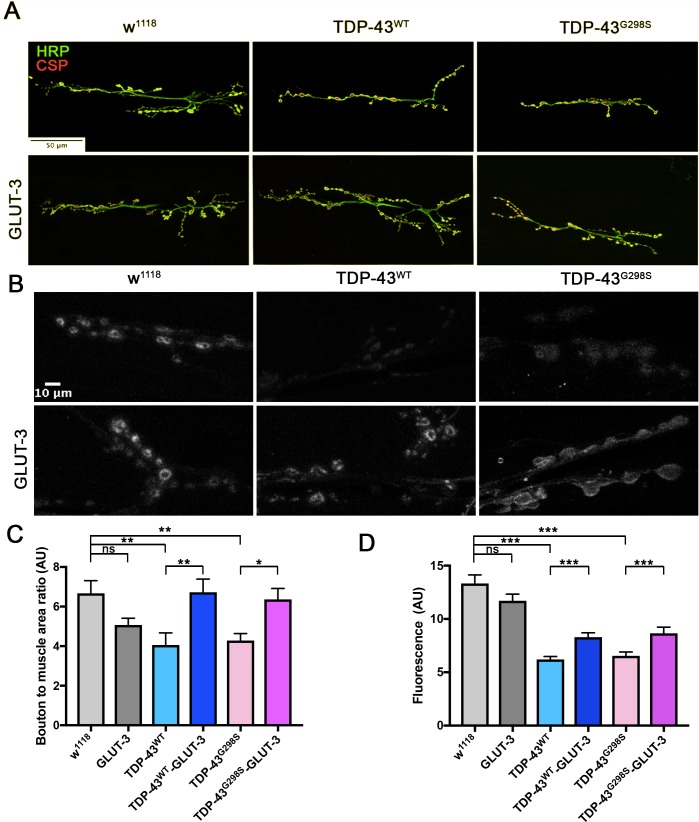
TDP-43 dependent defects at the NMJ are rescued by GLUT-3.Third instar larvae NMJ from segment A3, muscle 6/7 were immunostained for CSP and HRP (A) or analyzed for their ability to endocytose FM1-43 dye upon stimulation with 90 mM KCl (B). (A, C) Neuronal TDP-43 expression in Drosophila neurons reduces the number of boutons (labeled with CSP and HRP (A, C) and reduces FM1-43 dye uptake (B, D). These morphological (A, C) and functional (B, D) deficits are rescued by co-expression of GLUT-3. N = 7–10 larvae. Kruskal-Wallis test was used to identify significance.10.7554/eLife.45114.023Figure 5—source data 1.Bouton count analysis and FM1-43 GLUT-3 analysis.